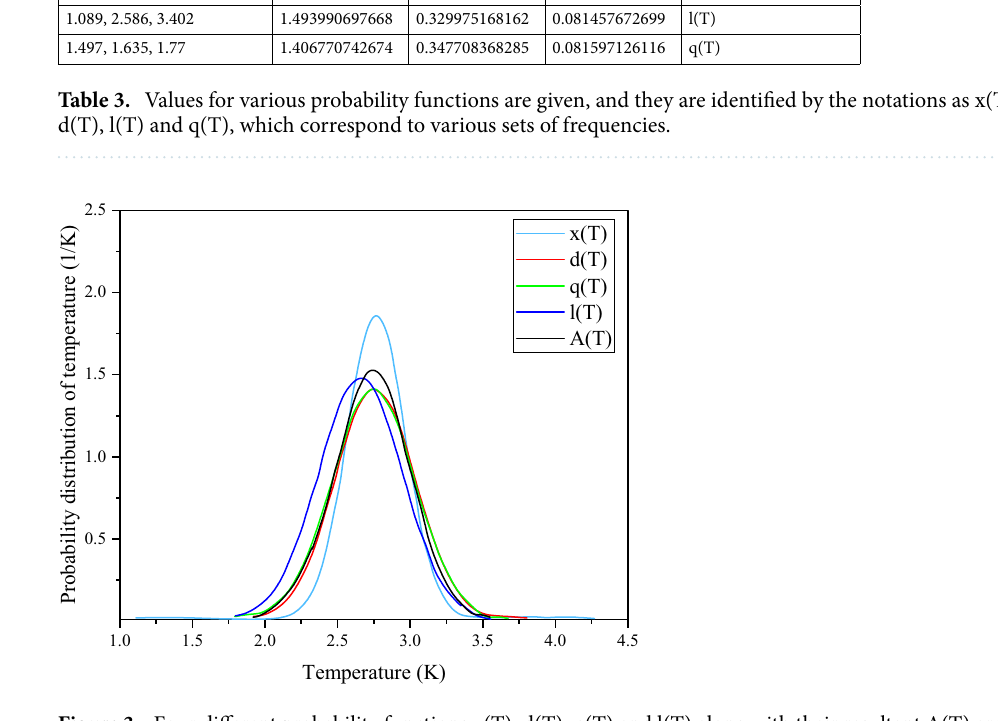
Figure 3. Four different probability functions x(T), d(T), q(T) and l(T) along with their resultant A(T) are plotted against absolute temperature. The scales are taken considering the clear view of the